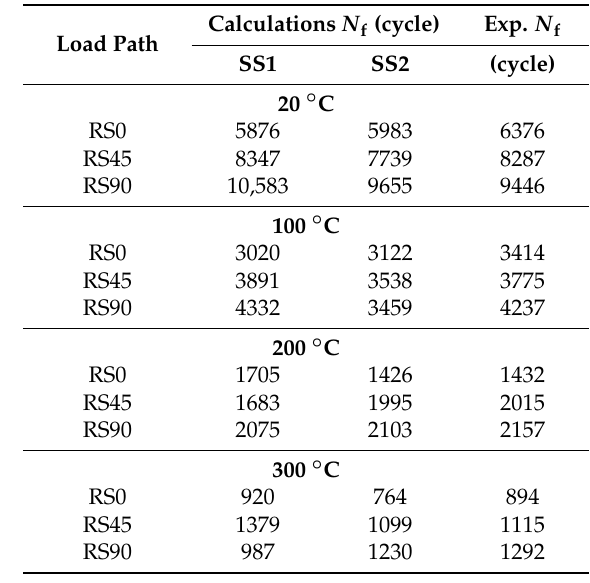
Table 6. Comparison of the results of numerical simulations using the SS1 model (Szusta Seweryn 2015) and SS2 model (Equation (10)) and experimental tests of the number of cycles N f for different loading paths (EN AW-2024